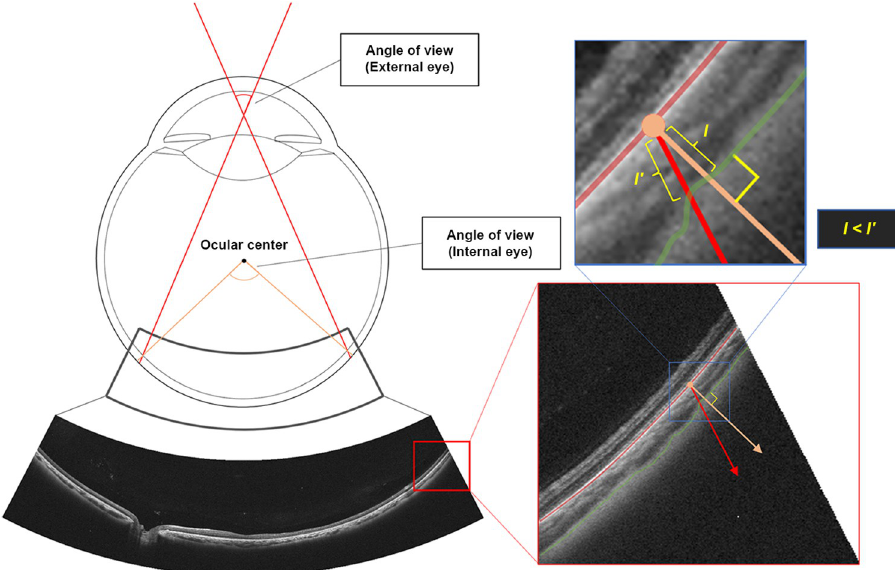
Fig 1. Using UWF-OCT to measure CT. Using UWF-OCT to measure CT thickness, based on light rays incident from the outside of the eye, may overestimate the thickness between the retinal pigment epithelium (red line) and the choroid–sclera boundary (green line) because the measurement is oblique to the fundus (l 0 ). Thus, measuring CT using the center of the eye, which was set on the basis of the measured eye shape, made it possible to measure the thickness more accurately, even with UWF-OCT, because the measurement direction became almost vertical to the fundus (l). Abbreviations: UWF-OCT, ultrawide field optical coherence tomography; CT, choroidal thickness.